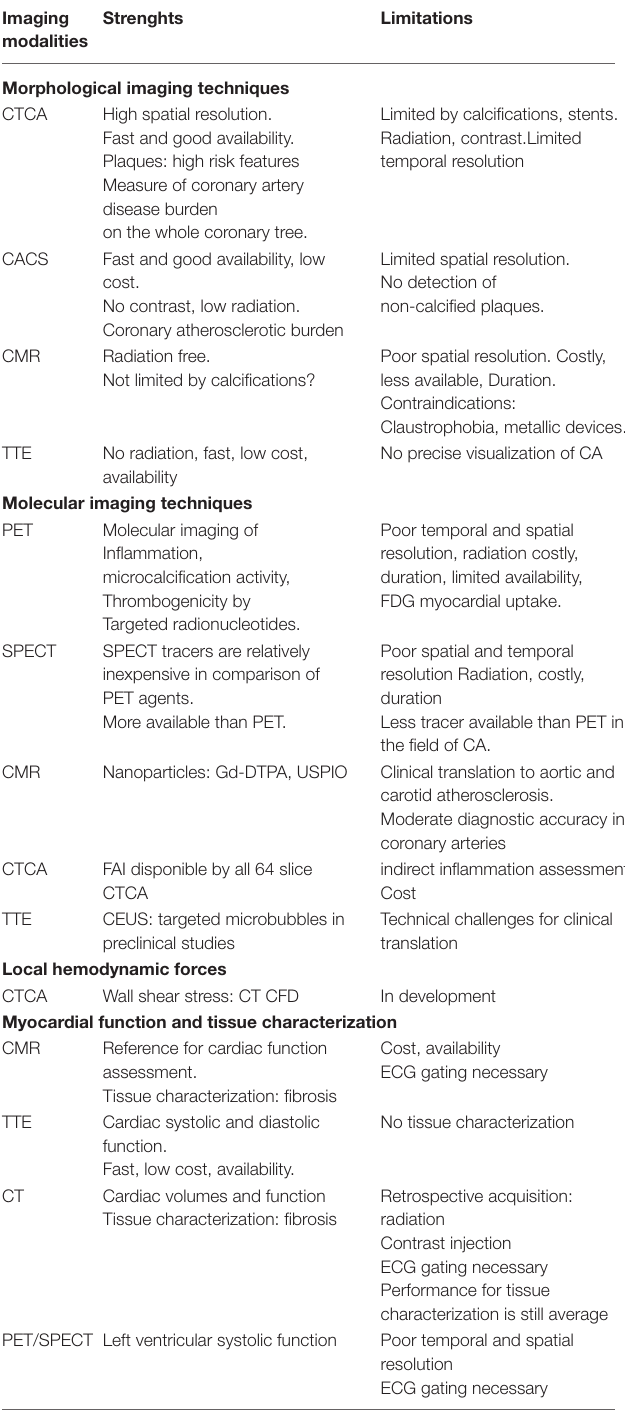
TABLE 1 | Non-invasive multimodal imaging assessment of vulnerable plaques and patients in chronic coronary syndrome. Imaging modalities